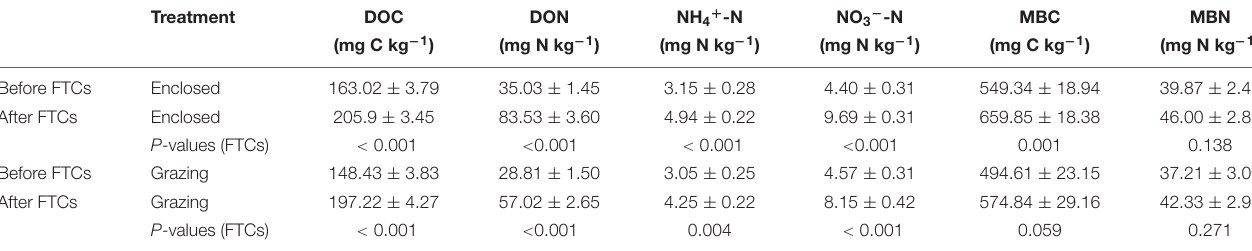
TABLE 1 | One-way ANOVA of the effect of FTCs on soil characteristics and microbial biomass carbon and nitrogen.